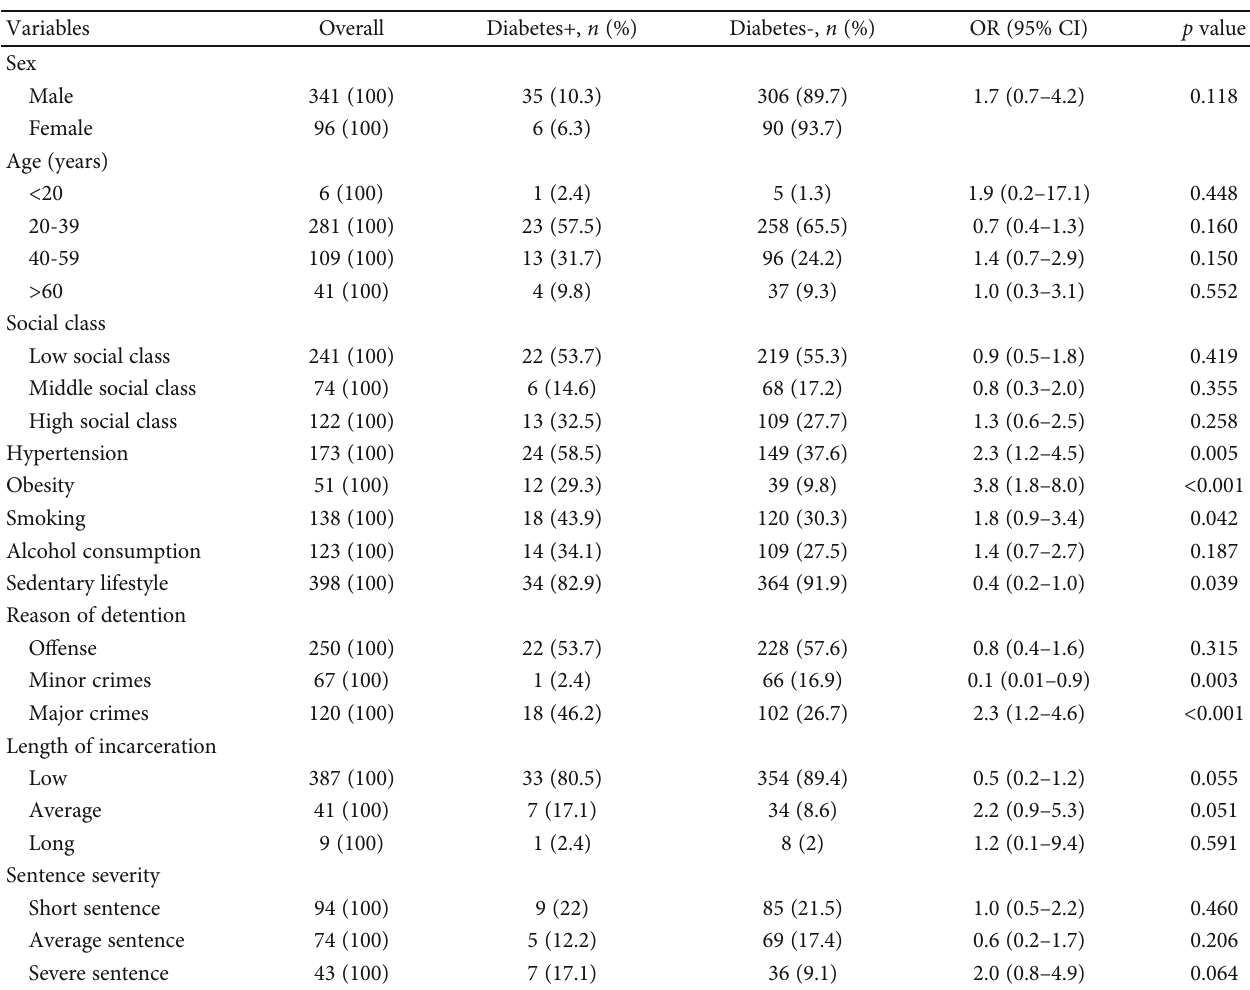
Table 1: Risk factors associated with diabetes among inmates in univariate